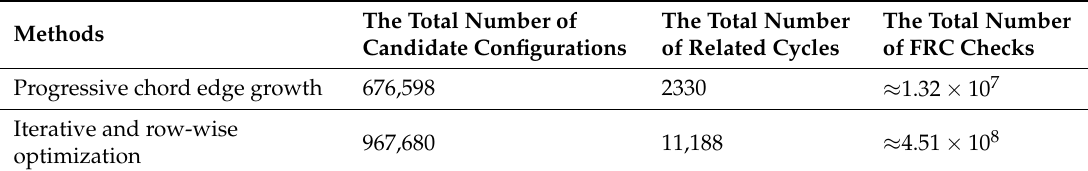
Table 1. The complexity of the optimization for the NB-LDPC code with the code rate of